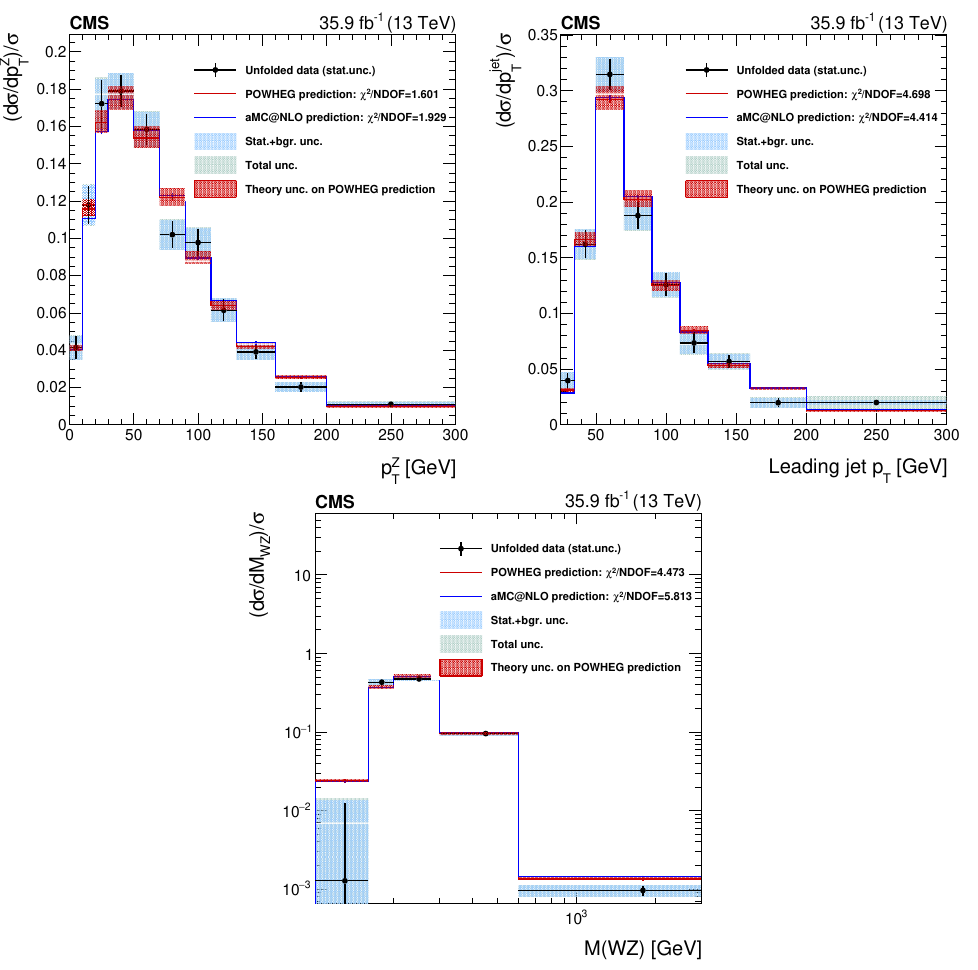
Figure 10 . Di(cid:11)erential distributions for the Z boson p T (top left), leading jet p T (top right), and mass of the WZ system (bottom). Data distributions are unfolded at the dressed leptons level and compared with the powheg , MadGraph 5 a mc@nlo NLO generators, and pythia predictions, as described in the text. The red band around the powheg prediction represents the theory uncertainty in it; the e(cid:11)ect on the unfolded data of this uncertainty, through the unfolding matrix, is included in the shaded bands described in the